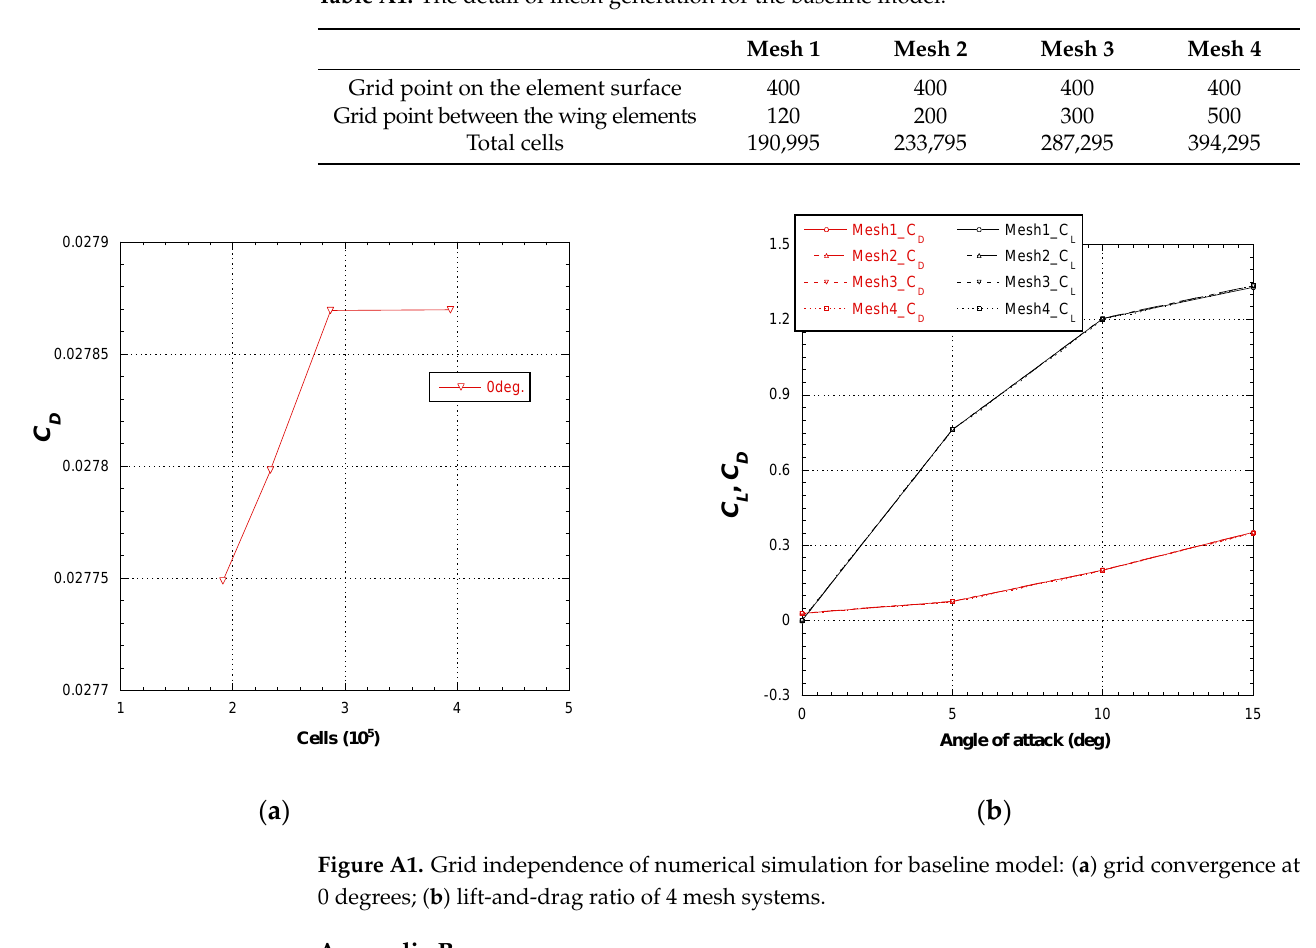
Table A1. The detail of mesh generation for the baseline model.